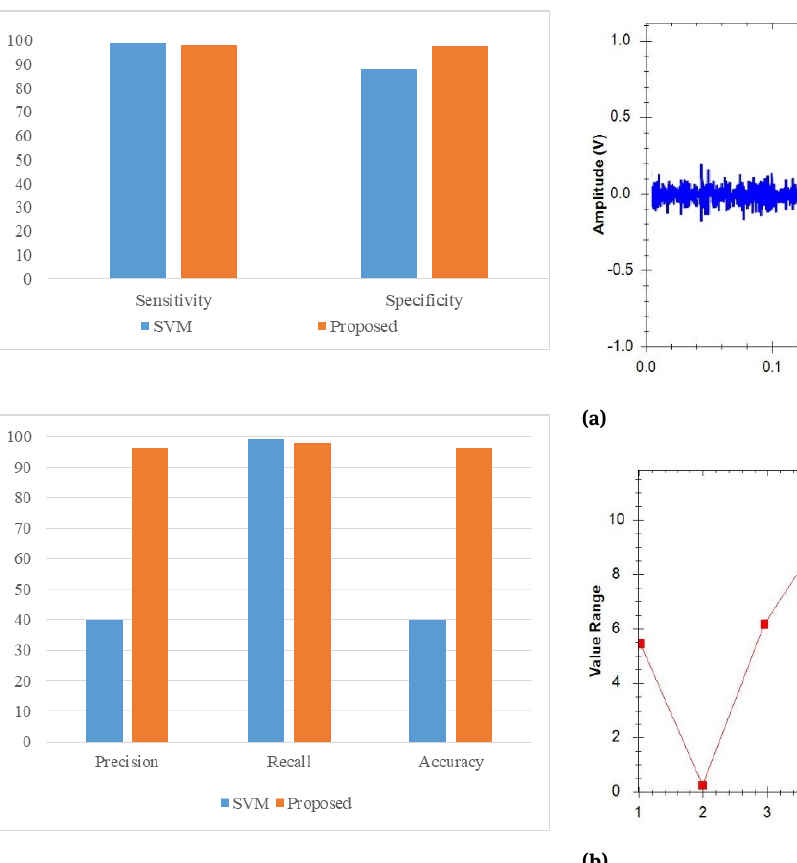
Figure 5: Feature analysis in time domain for fault diagnosis: (a) waveform in time domain of the first signal; (b) statistical features of first signal in time